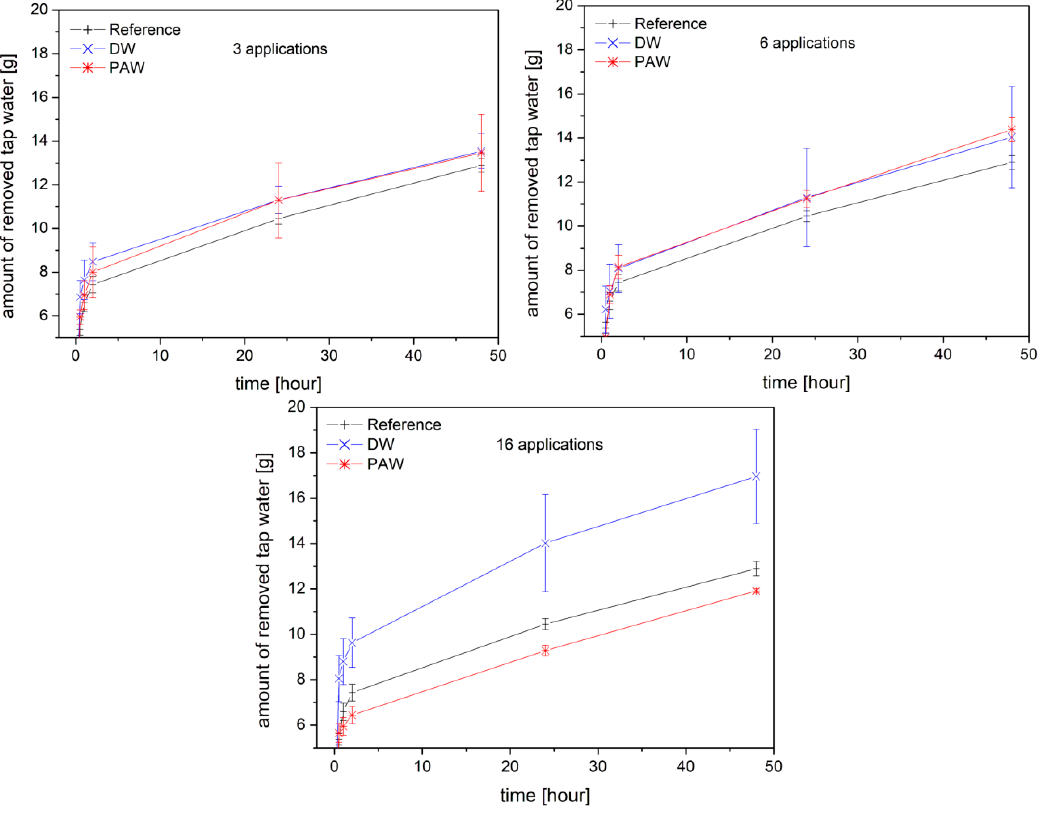
Figure 8. Removal of tap water at the selected number of DW and PAW applications.